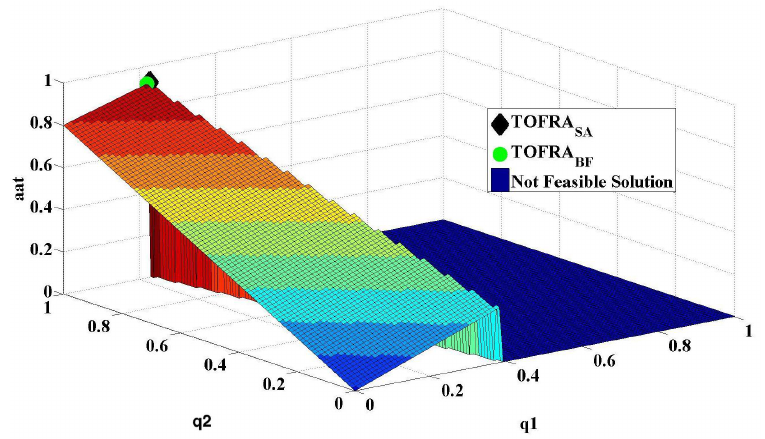
Figure 11. Simulated annealing vs. brute force, test case 3: Topology = 1, γ = 1.0, Interference handling: SIC( R ).